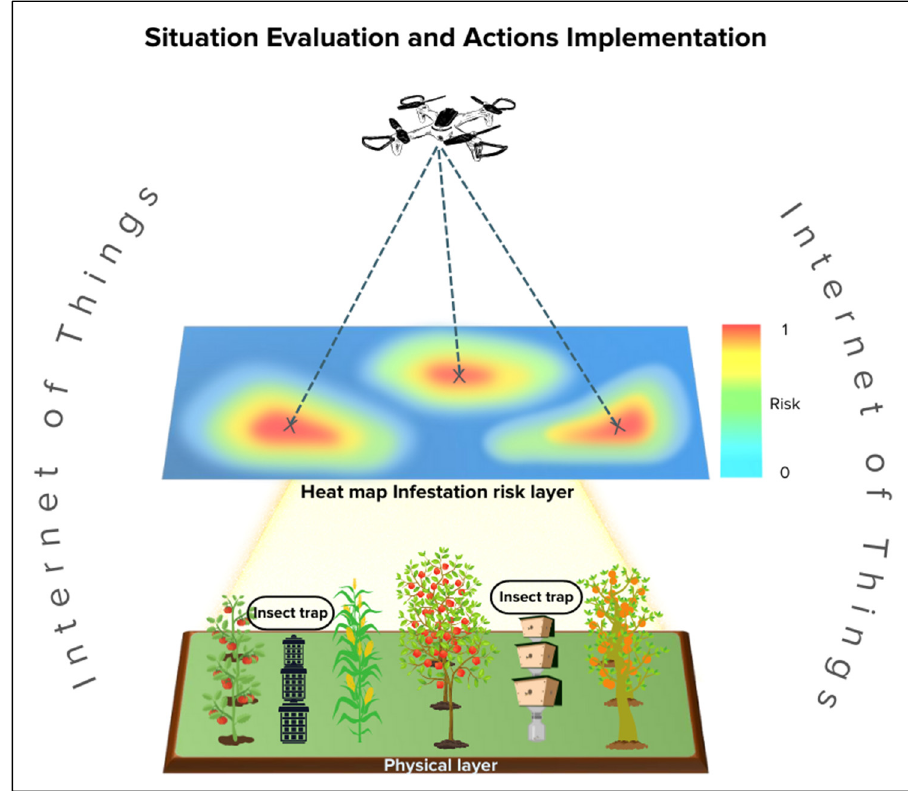
Figure 8. Evaluation of pests and encountering remedies in smart farming. Table 3. Techniques and goals for monitoring pests and input management in smart